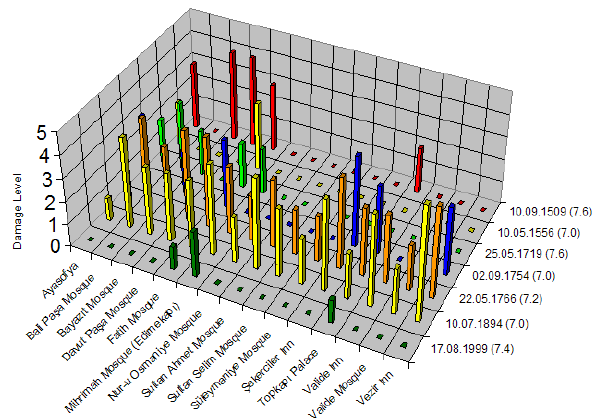
Fig. 14. Earthquake damage in historical structures in Old ˙Istanbul area l (Fatih-Emin¨on¨u districts) (Erdik et al., Figure 14. Earthquake damage in historical structures in Old İ stanbul area l (Fatih-Eminönü districts) (Erdik et al., 2001)